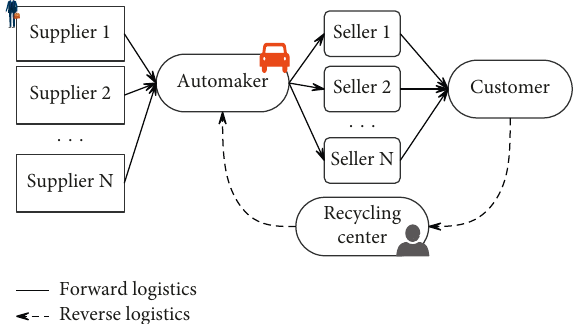
Figure 7: Automobile reverse logistics inventory model.